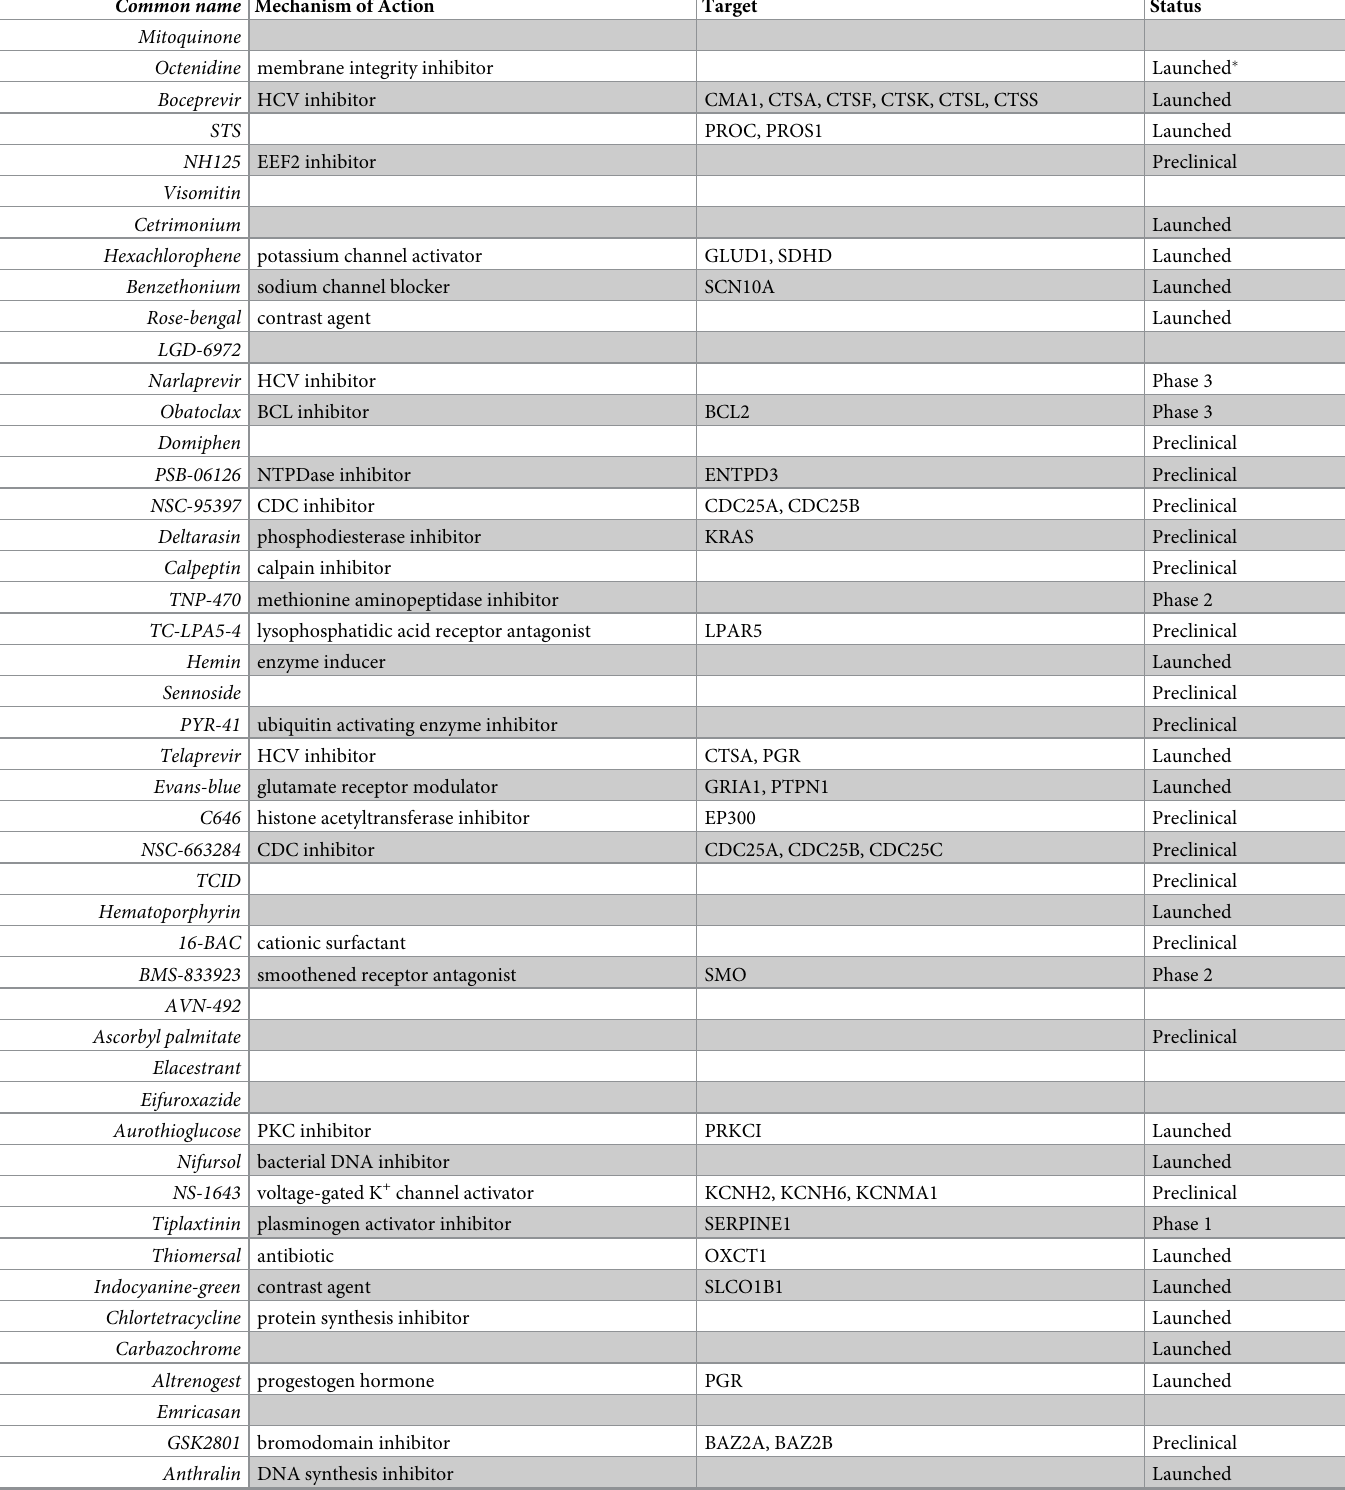
Table 1. Hits identified from Broad Repurposing Library screen against SARS-CoV-2